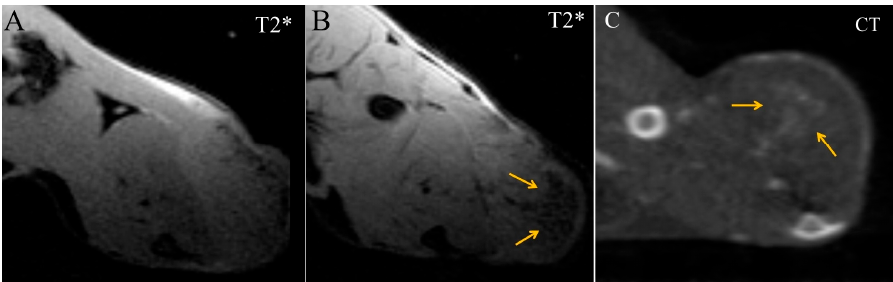
Figure 5. Transversal images of Ca755 mammary carcinoma. ( A ) native T2* MRI; ( B ) T2* MRI 16 min post injection of Fe 3 O 4 @Au; ( C ) CT image 22 min post injection of Fe 3 O 4 @Au. Arrows mark a triangular-shaped area of accumulation.